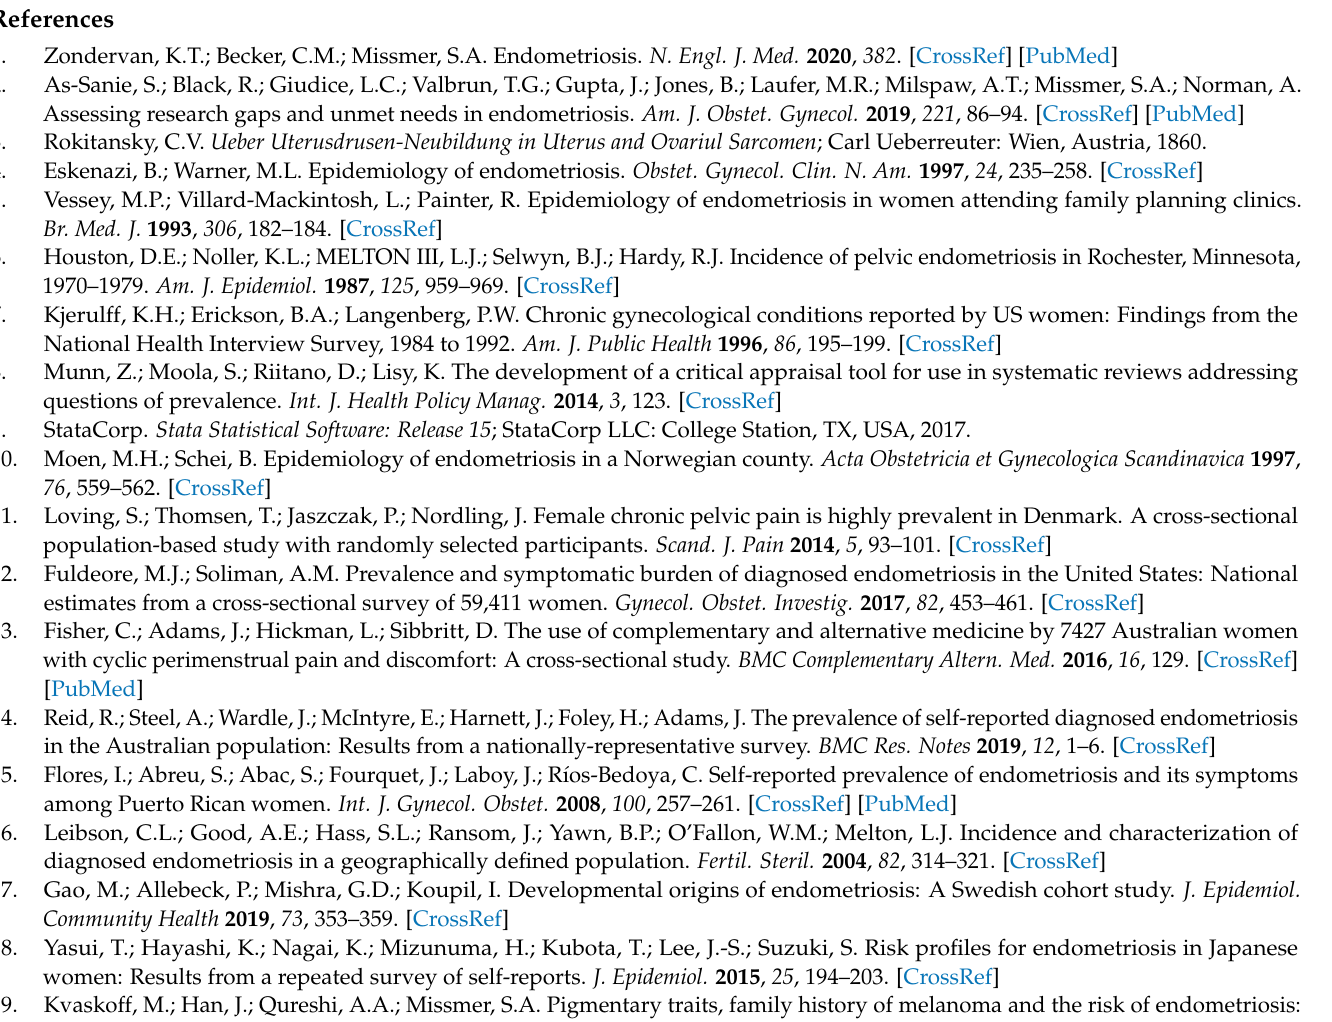
Figure A2. Funnel plot for incidence data. Note: blue dots represent individual studies; the outer dotted line indicates the triangular region within which 95% of studies are expected to lie in the absence of both biases and heterogeneity; the solid vertical line represents the line of no effect, derived using fixed-effect meta-analysis.